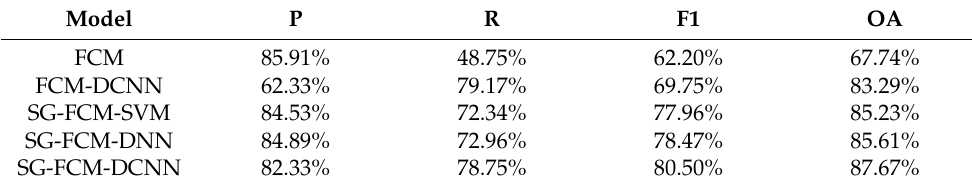
Table 3. Statistical comparison of models’